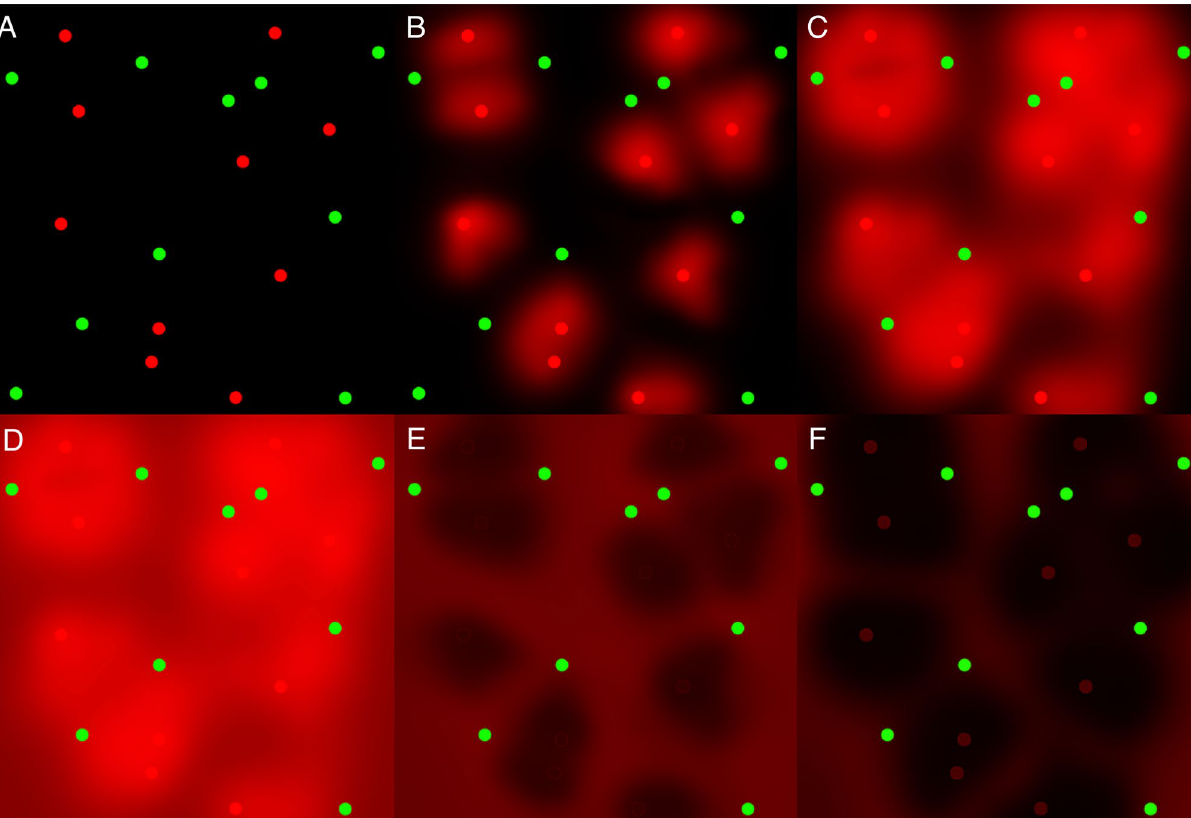
Figure 6. Schematic of the progression in time of blood flow in the choriocapillaris units as observed in this study on ICGA. The red dots represent arterioles and the green dots venules which are randomly distributed ( A ). As blood enters the choriocapillaris via the arterioles, they expand and flow toward venules. The direction and extent of flow is governed by the pressure gradient and distance between the surrounding arterioles and venules ( B , C ). The flow from an arteriole outward would be more for a closer vein draining than a distant one. Zones between adjacent units that are last to fill are noted, which also vary in width and shape ( D ). Note that these darker zones do are not centered around draining venules, but represent regions furthest from arterioles. As the blood flow in central part of each unit becomes constant, dye flow was observed in the perimeter of each units and the zones between adjacent units ( E , F